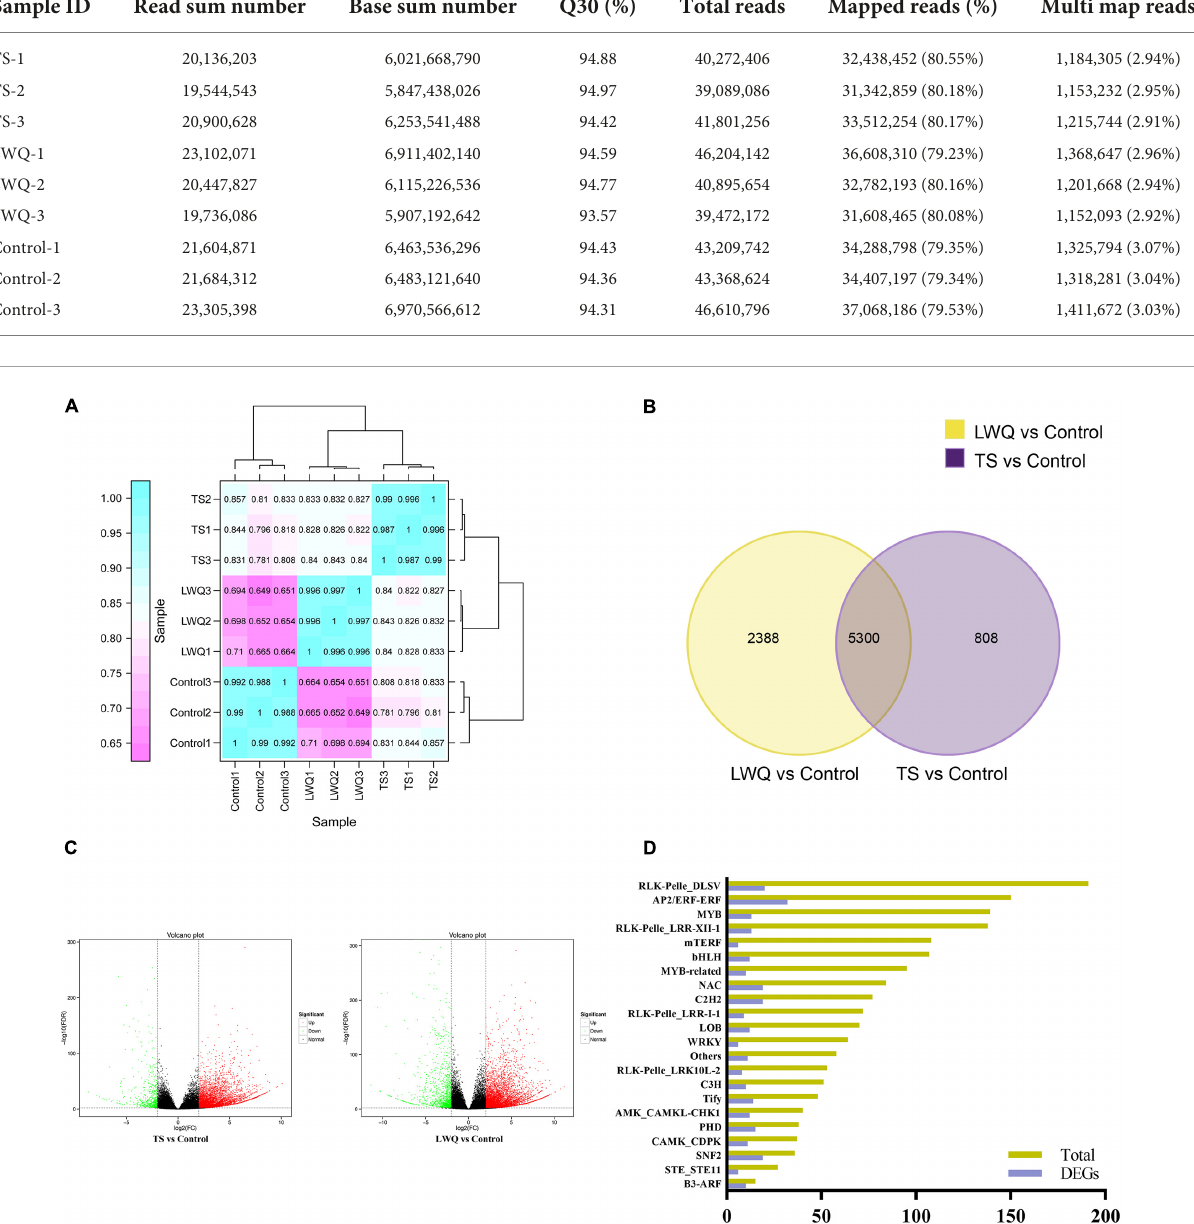
TABLE 4 Overview of the transcriptome sequencing dataset and quality check.